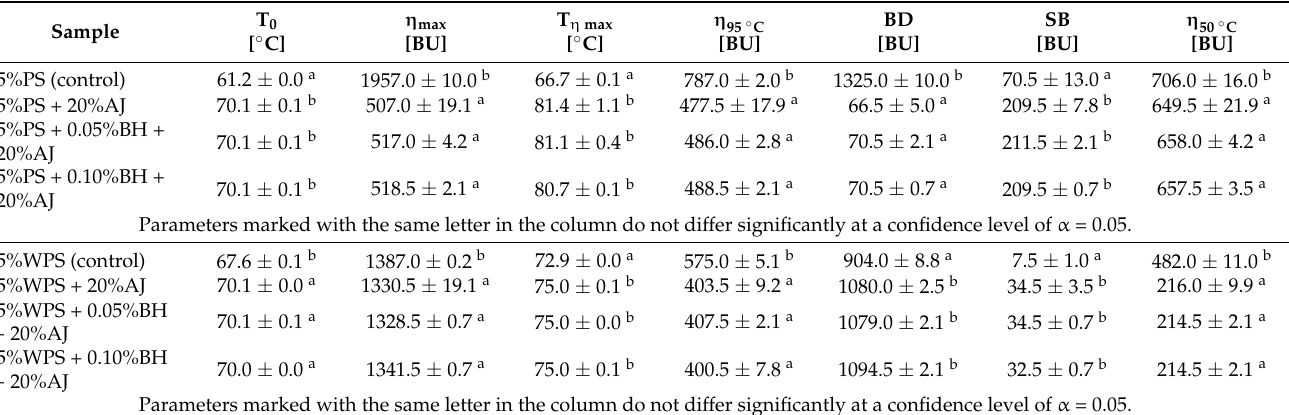
Table 2. Parameters of the pasting characteristics of potato starch gels and starch gels with buckwheat fiber.